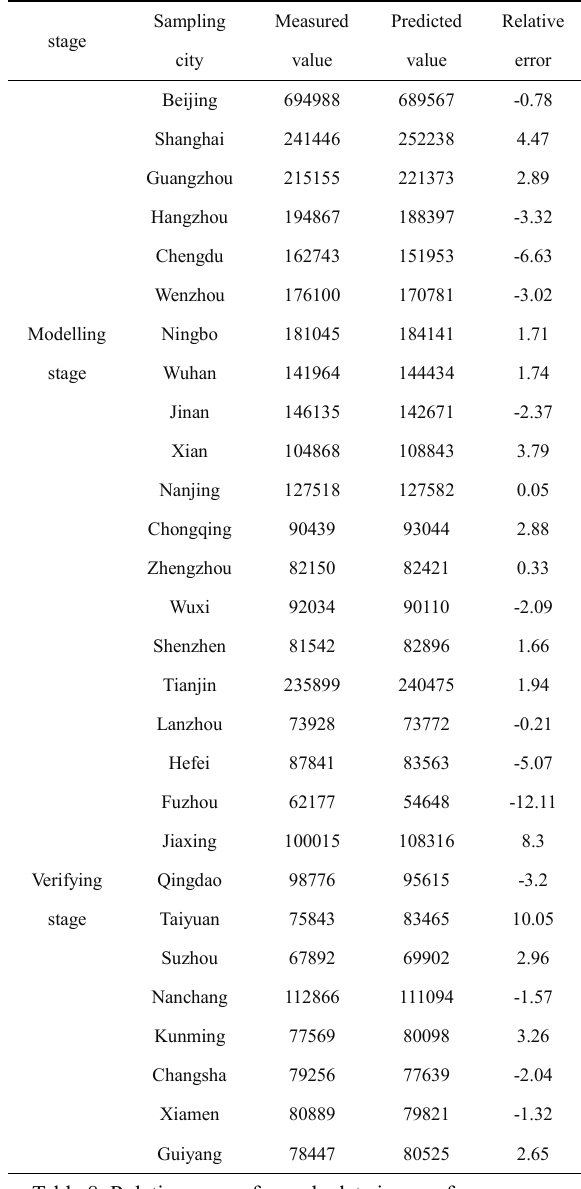
Table 8. Relative error of sample data in pcr of user access